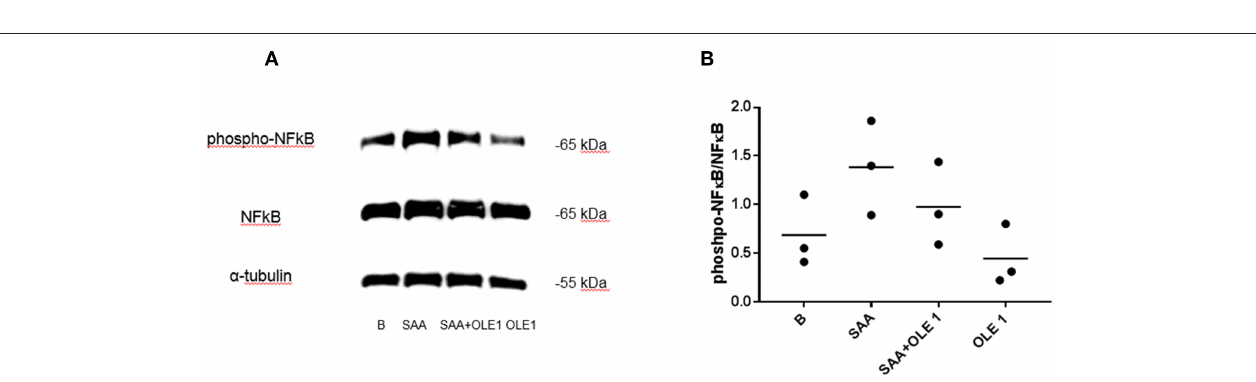
FIGURE 3 | OLE attenuates SAA-induced phosphorylation of NF- κ B. (A) Western blot shows phosphorylation of NF- κ B in HCAEC pretreated with OLE for 1h and then treated with OLE ± SAA for 1h (SAA 1,000nM, OLE 1 mg/ml). Representative blot of n = 3 biological replicates. (B) Densitometry analysis of protein bands was carried out using the Fusion FX software (Vilber Lourmat), n = 3 biological replicates. For quantification of Western blots, the levels of phosphorylated NF- κ B were normalized to the levels of total NF- κ B. Equal amounts of protein were loaded per gel pocket. α -tubulin was used as a loading